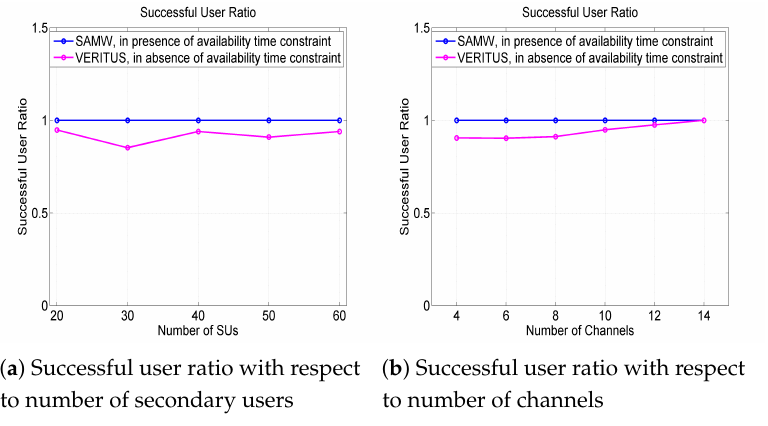
Figure 12. Successful user ratio for SAMW and